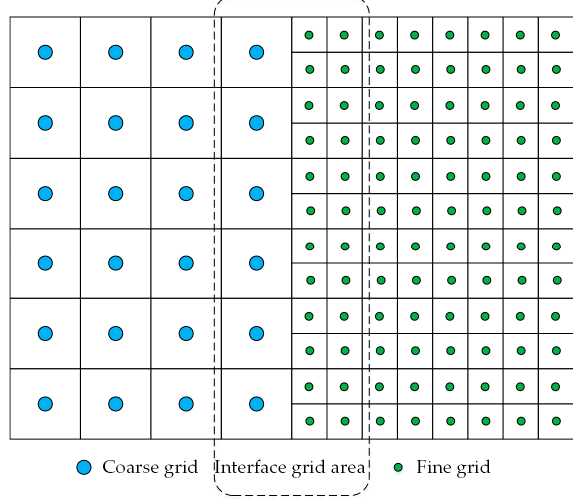
Figure 7. Schematic diagram of the interface of the coarse and fine grids in 2D.